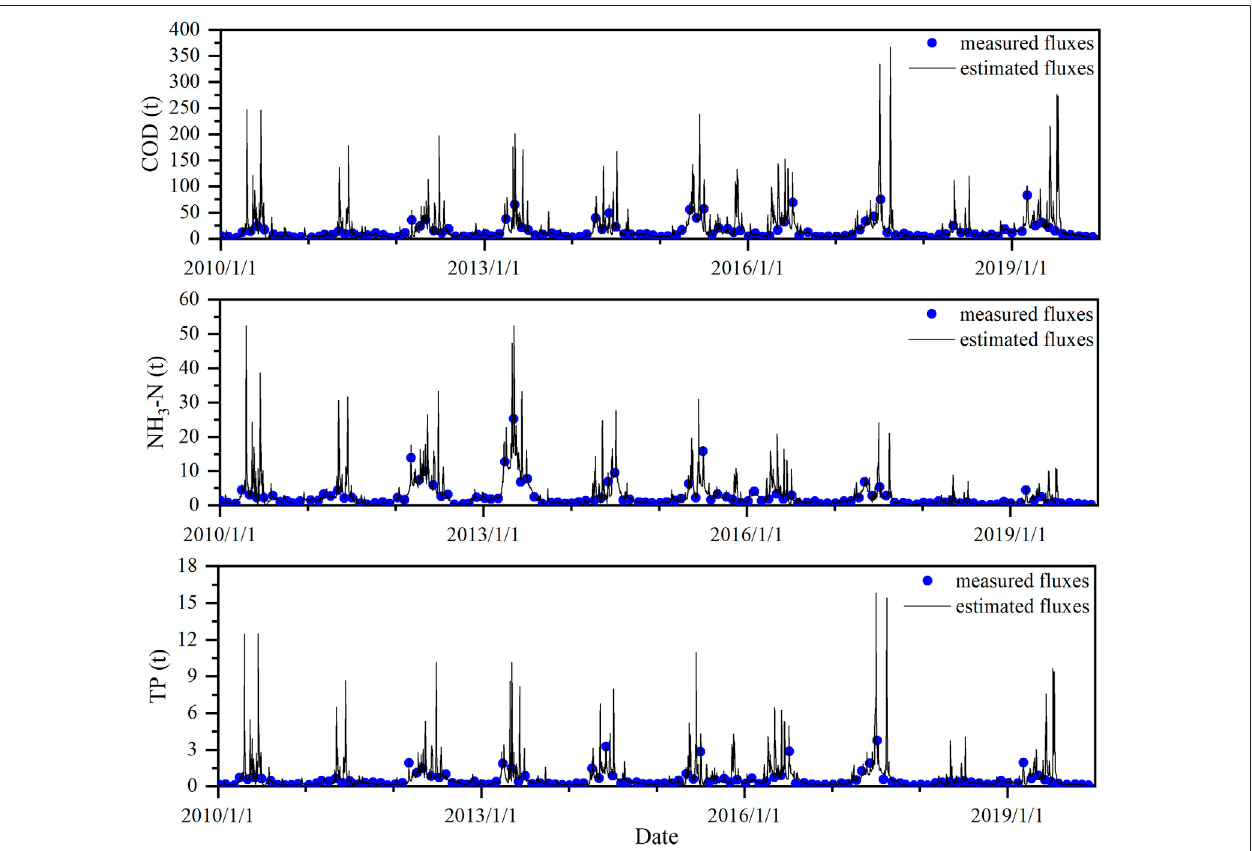
FIGURE 6 | Pollutant fl ux estimation with measured